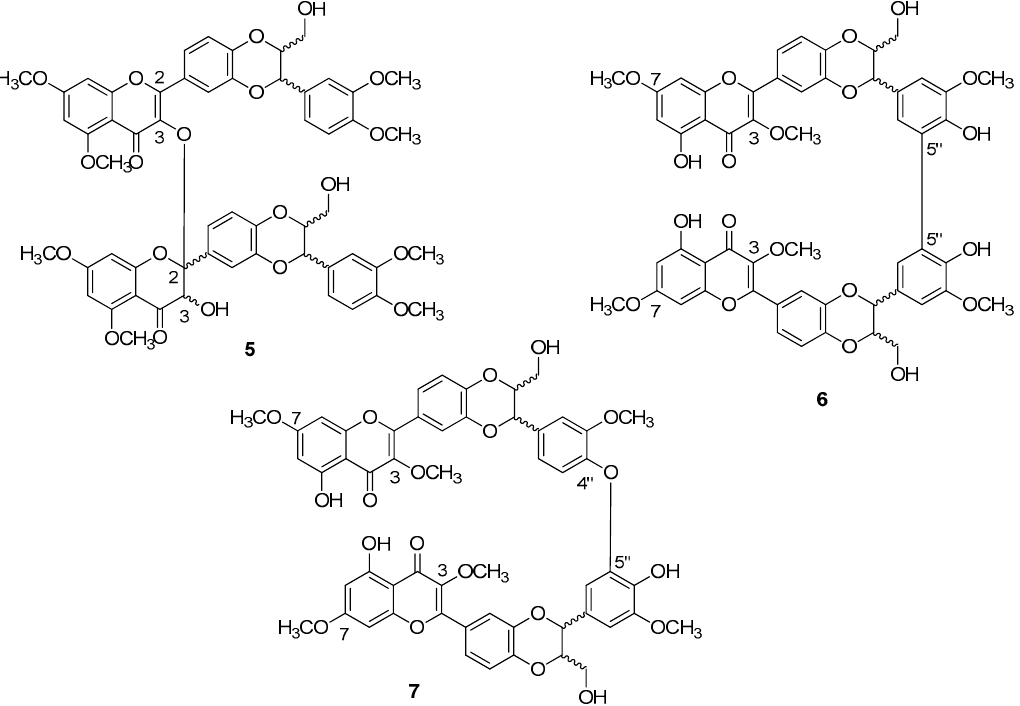
Figure 4. Bi -flavonolignans from dehydro-silybin oxidation.